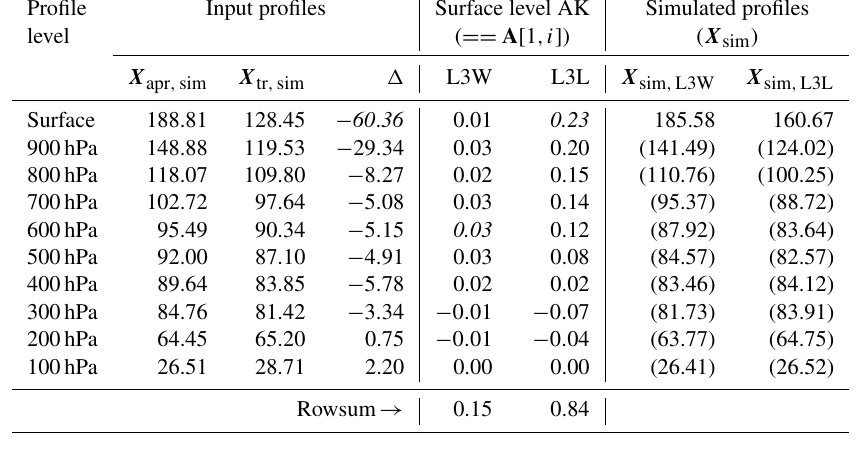
Table 2. Case study information for simulated L3L and L3W profile retrievals ( X sim , L3L and X sim , L3W respectively) for 18 August 2013. (cid:49) = X apr , sim − X tr , sim . Values that are italicized indicate the maxima (by magnitude) for that column. Simulated profile values for levels 900–100hPa are shown in brackets because AKs and calculations for these levels are not discussed in the text and AKs for the 900–100hPa levels are not shown.